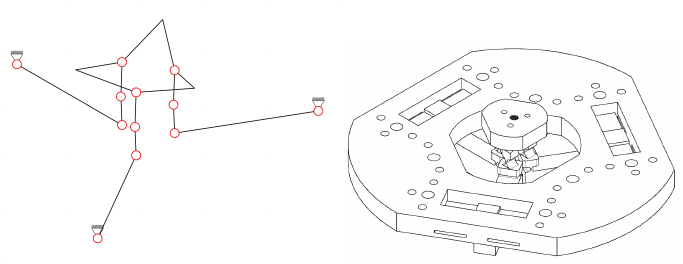
Figure 5. Lower sub-structure of the two-in-one